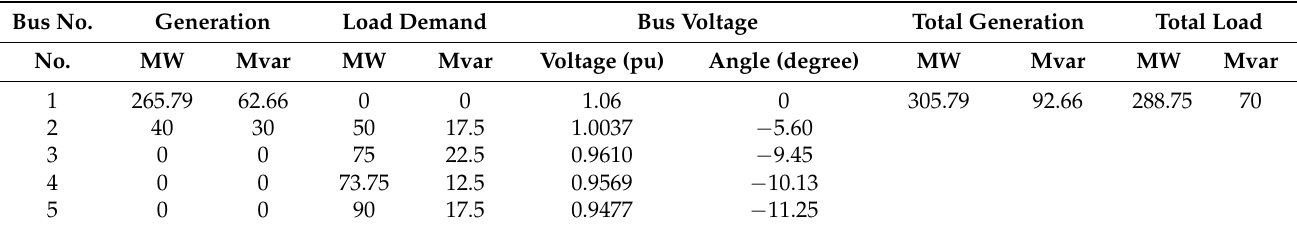
Table 4. Load flow results of the IEEE 5 bus system of case 3.